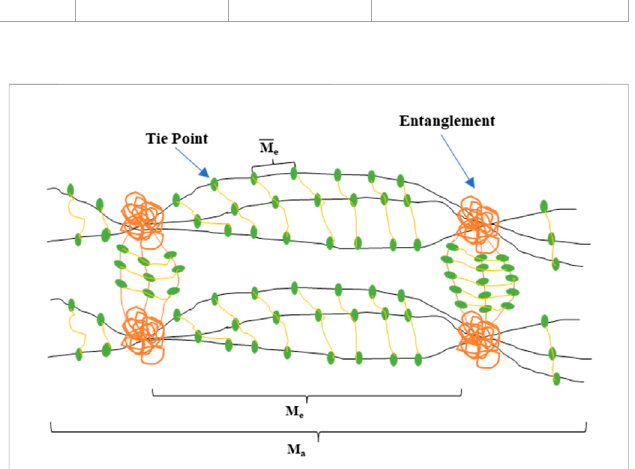
FIGURE 3 Nano silica-enhanced gel system network diagram (Zareie et al.,